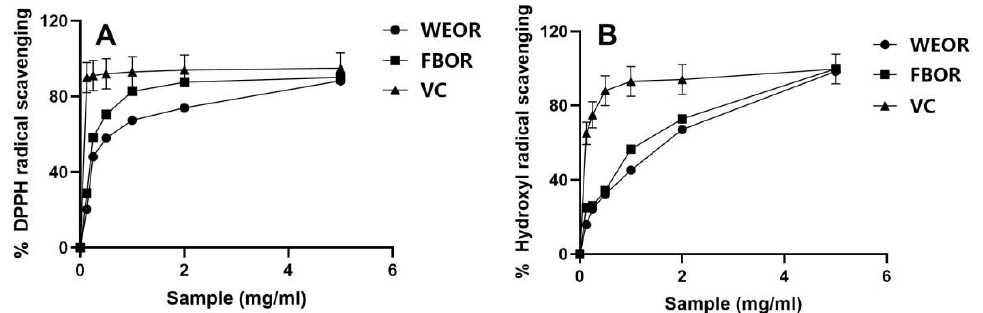
Figure 1. Different in vitro experiments were used to explore the antioxidant capacity of Lactobacillus plantarum fermented Rhodiola rosea and unfermented Rhodiola rosea. ( A ) DPPH free radical scav- enging activity of lactobacillus plantarum fermented Rhodiola rosea and unfermented Rhodiola rosea at the same concentration. ( B ) The hydroxyl radical scavenging activity of Lactobacillus planta- rum fermented Rhodiola rosea and unfermented Rhodiola rosea at the same concentration. Among them, Vitamin C (VC) is the positive control of the experiment.